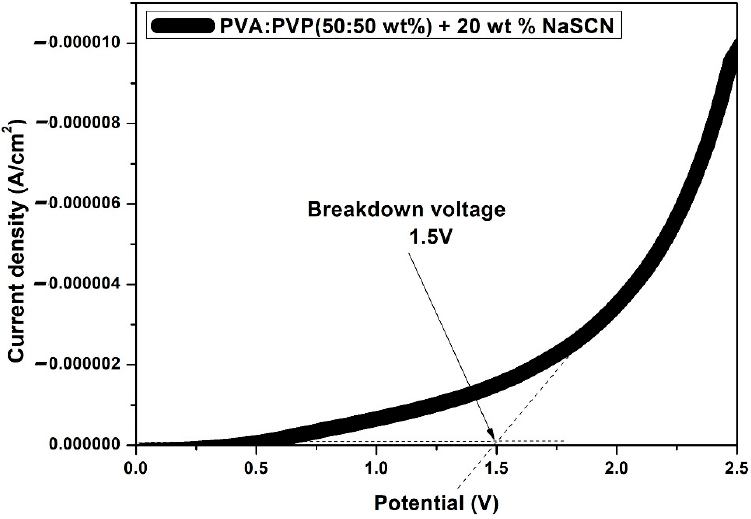
Figure 9. LSV plot for the cell: SS/ SPE /SS at scan rate 100 mV/s at room temperature.